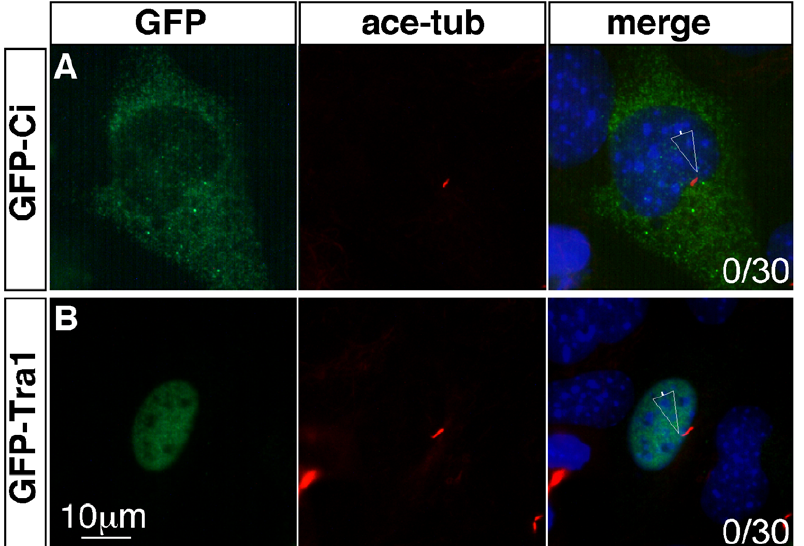
Figure 3. Invertebrate Gli homologues are not localized to cilia upon their introduction into vertebrate cells. (A) GFP-Ci is localized to the cytoplasm when over-expressed in the ciliated mouse MEFs. (B) GFP-Tra1 is localized to the nuclei when over-expressed in the ciliated mouse MEFs. Neither Ci nor Tra1 is localized to the tips of cilia. Immunofluorescent images of MEFs transfected with GFP-tagged proteins are shown. Cilia are labeled with acetylated tubulin and nuclei are stained with DAPI. In the merged images, filled arrowheads indicate GFP signals at the tips of the cilia, unfilled arrowheads indicate the tips of cilia without GFP signals. Numbers at the lower-right corners of each image indicate numbers of cells with ciliary localization of GFP-tagged proteins over total numbers of transfected cells.